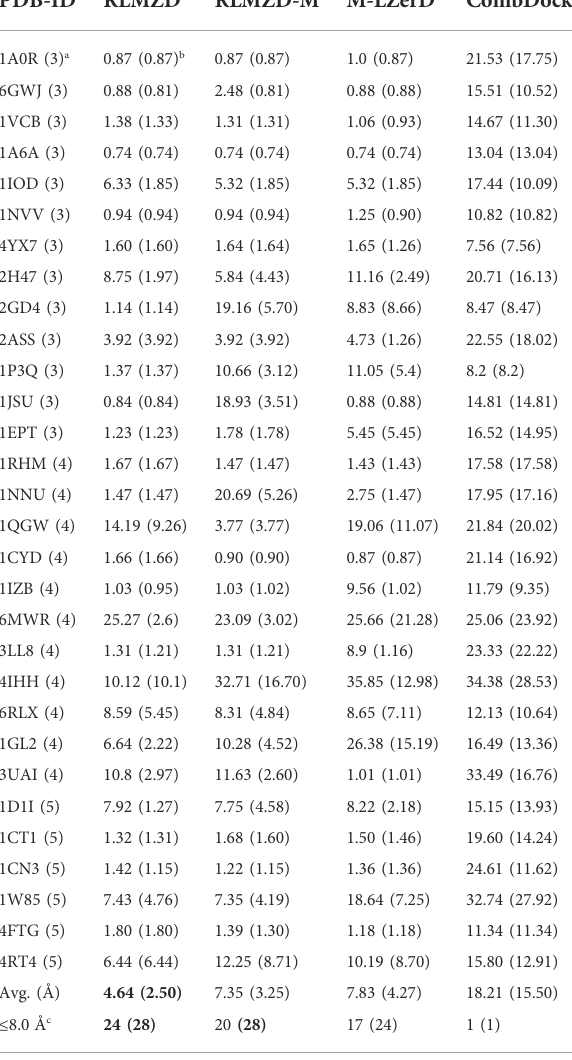
TABLE 1 RMSD of models for the bound docking